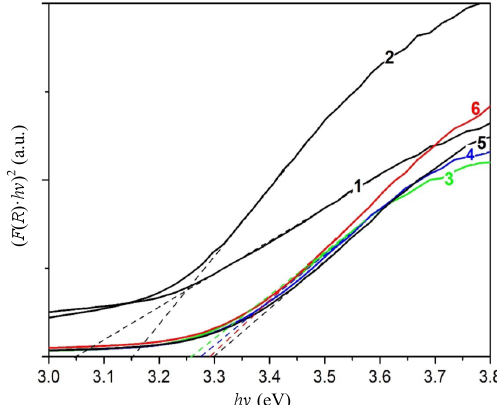
Fig. 4 Plots of modified Kubelka–Munk function 2 ( ( ) ) F R h  versus photon energy h  for all samples. Table 1 Gap energy E versus the composition of the g were estimated from the samples. The values of E g plots of the modified Kubelka–Munk function No.